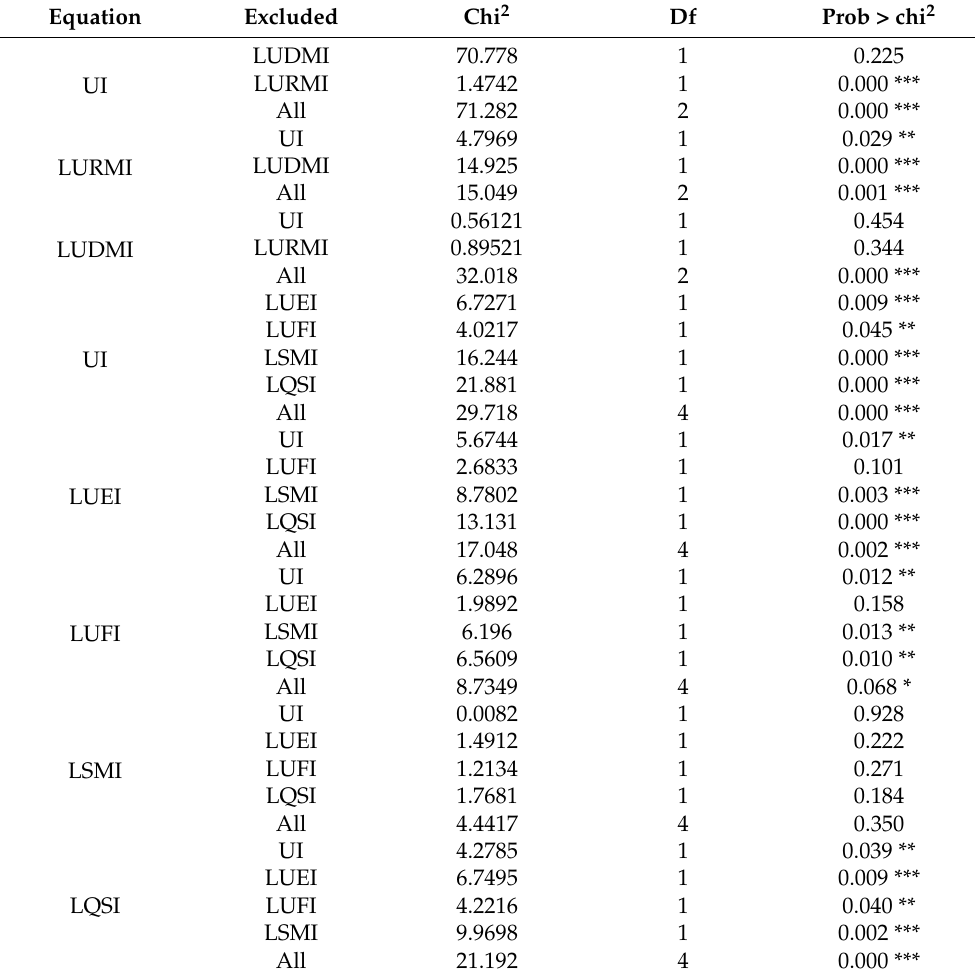
Table 7. Granger causality test for